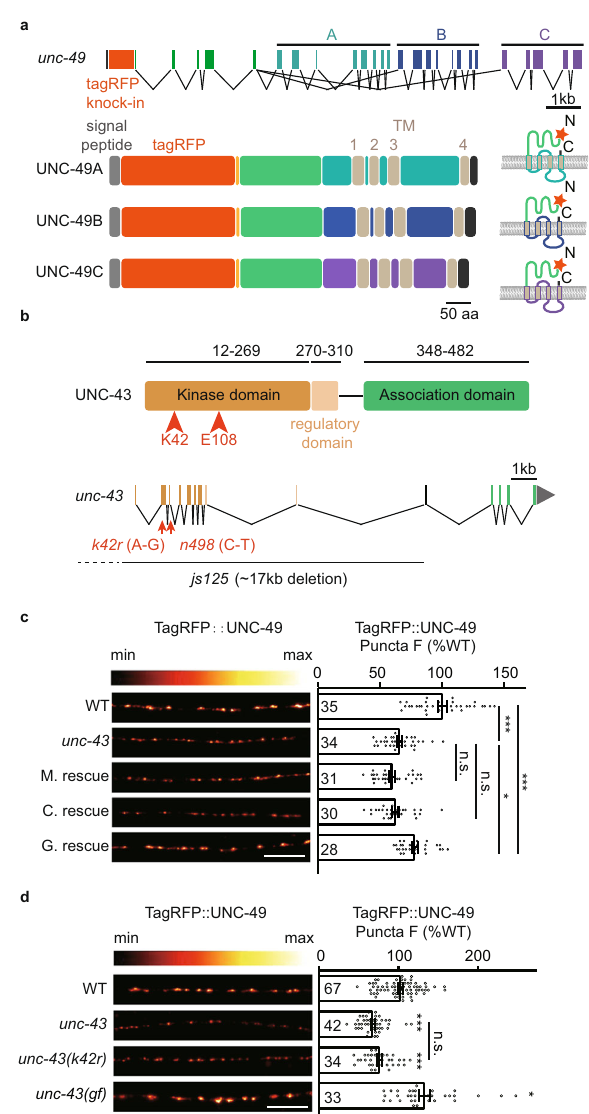
Fig.1|PresynapticUNC-43/CaMKIIregulatespostsynapticGABA A Rabundance atGABAergic synapses. a Schematic representation ofthe xj1024 locus. A tagRFP coding sequence was inserted before the fi rst exon shared by UNC-49A, UNC-49B, and UNC-49C. TagRFP consequently labels the UNC-49A, UNC-49B, and UNC-49C proteins. b TheproteinstructureofUNC-43isshownontop.The js125 mutationhas a 17kb deletion (upstream of the promoter to the 10th exon) that deletes most of the coding sequences. The kinase-dead mutant unc-43 ( k42r) has a point mutation and causes the K42R coding variant. The gain-of-function unc-43 (gf) (n498 , gain of function) mutant has a point mutation that causes single amino acid substitution E108K. c Thepuncta fl uorescenceintensitymarkedbyTagRFP-UNC-49(under unc- 49 ownpromoter)indorsalnervecordaxonswasdecreasedinthe unc-43 mutants. This defect was rescued by transgenic expression of UNC-43 in GABAergic motor neurons (G. rescue), but not by UNC-43 expression in cholinergic neurons (C. rescue) or in body-wall muscles (M. rescue). Representative images (left, scale bar 10 μ m, Pseudo-color: Red Hot) and mean puncta intensities+/ − SEM (right, Ns representthenumberofanimalstested)areshown.One-wayANOVAwithpost-hoc Bonferroni ’ s multiple comparison test. * p <0.05, *** p <0.001, n.s. not signi fi cant. d GABA A R fl uorescence intensity is decreased in the unc-43 ( k42r ) kinase-dead mutants, and increased in the unc-43(gf) (n498 , gain of function) mutants. Repre- sentative images (left, scale bar 10 μ m, Pseudo-color: Red Hot) and mean puncta intensities+/- SEM (right, Ns represent the number of animals tested) are shown. Kruskal – Wallis test with post-hoc Dunn ’ s test. * p <0.05, *** p <0.001, n.s. not sig- ni fi cant. For c , d , source data are provided as a Source Data fi